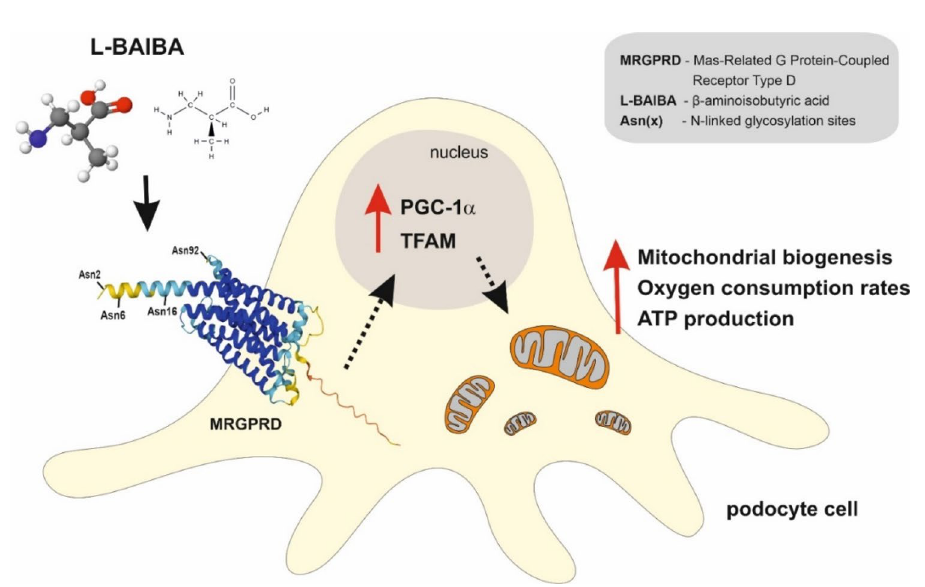
Figure 5. Schematic representation of potential mechanism of L-BAIBA action on mitochondria and respiratory functions in